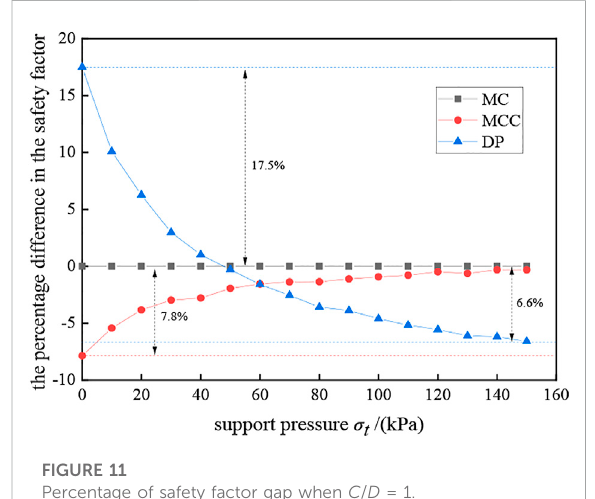
Percentage of safety factor gap when C / D = 1.